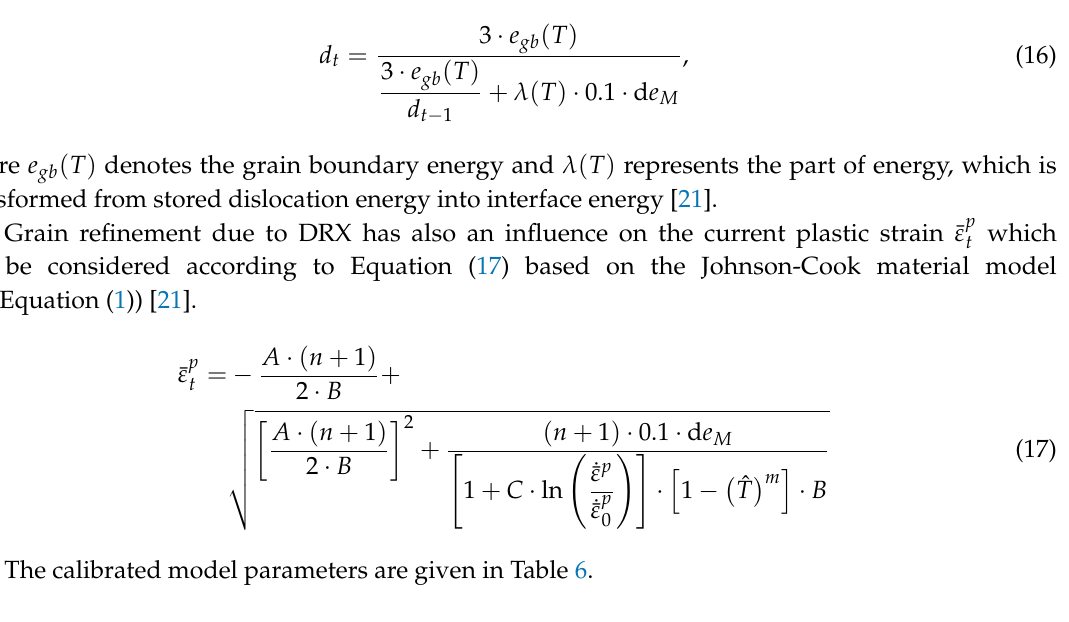
Table 6. Helmholtz free energy model parameters of AISI 4140 based on